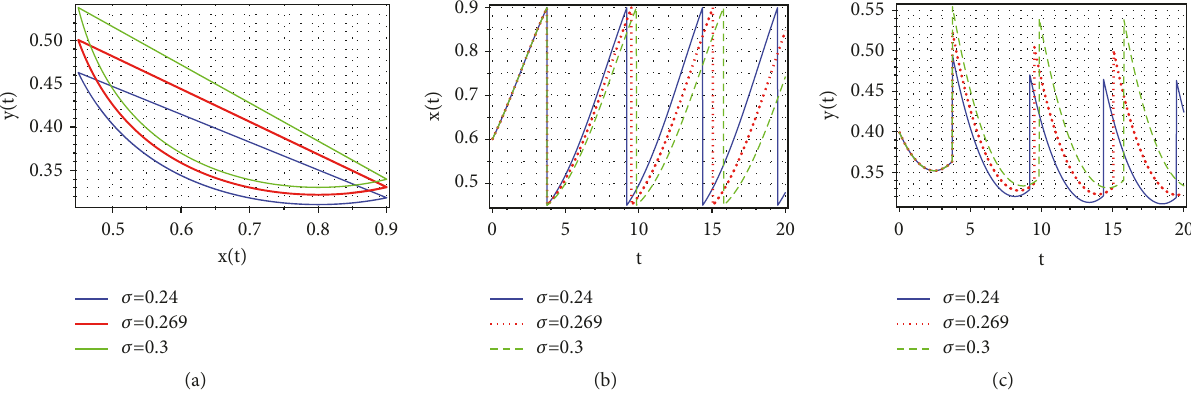
Figure 7: Numerical simulations in case 0 < max {𝑥 ∗ ,ℎ 1 } < ℎ < ℎ 0 < ℎ 2 . (a) Phase portrait of 𝑥(𝑡) and 𝑦(𝑡) on ℎ = 0.9 . (b) Time series of 𝑥(𝑡) . (c) Time series of 𝑦(𝑡)